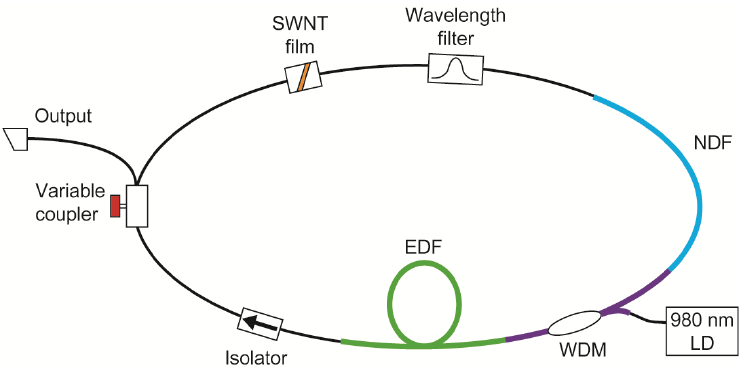
Figure 1. Configuration of passively mode-locked, Er-doped, ultrashort-pulse fiber laser with SWNT polyimide film. WDM, wavelength-division-multiplexed coupler; EDF, Er-doped fiber; NDF, normal-dispersion fiber.